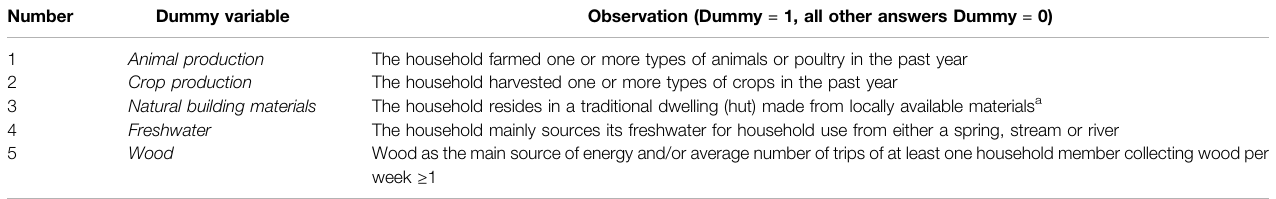
TABLE 1 | Composition of the characteristic bundle of ES adopted from Hamann et al. (2015) for both census and KIDS data. Number Dummy variable Observation (Dummy = 1, all other answers Dummy =